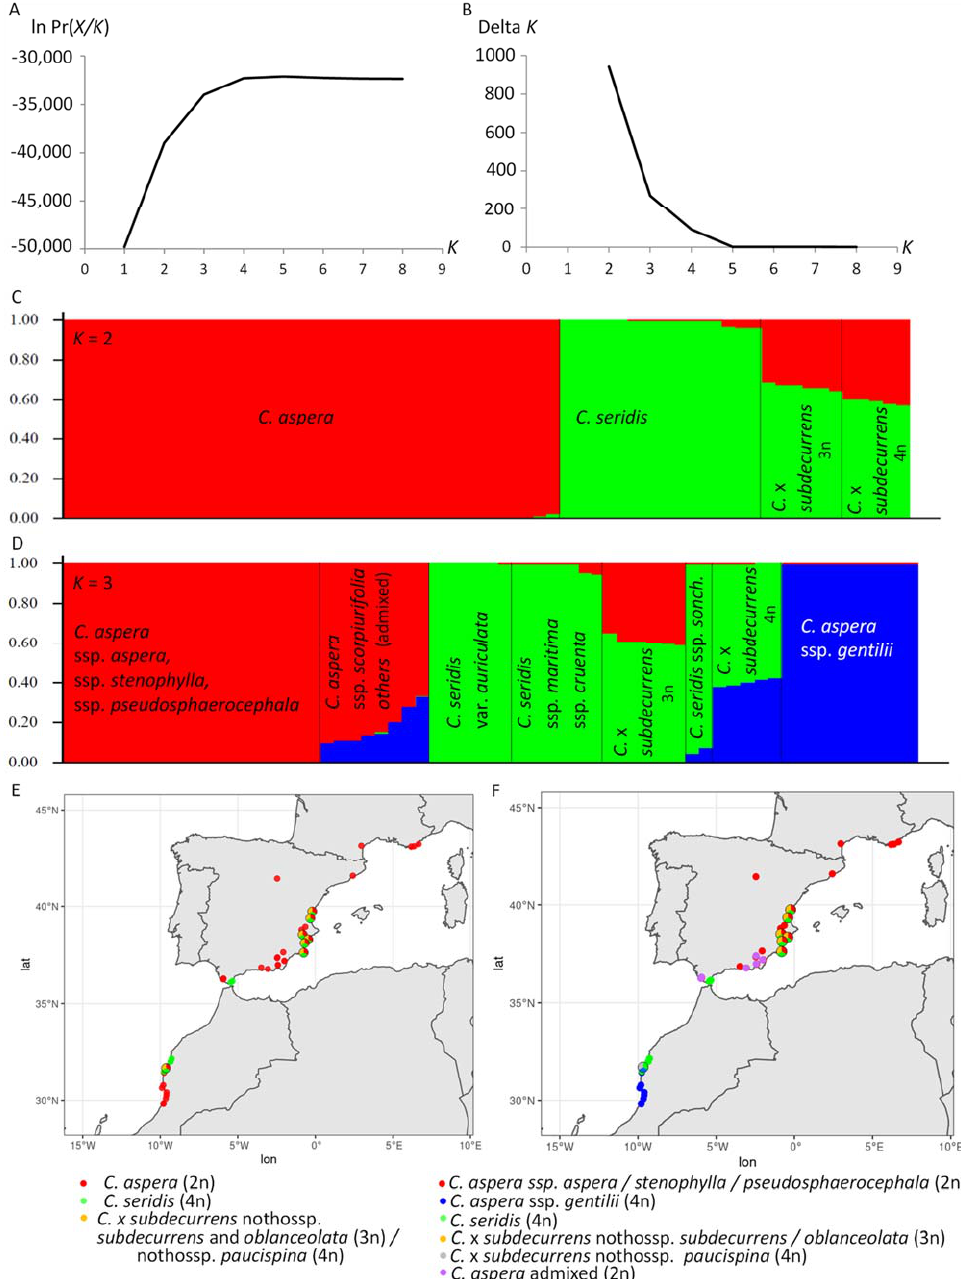
Figure 1. STRUCTURE clustering analysis for Centaurea aspera , C. seridis and C. x subdecurrens hybrids between them in the studied area. ( A ) Diagram representing log-likelihood of the SNP data for Centaurea individuals given K clusters obtained through 10 runs with the algorithm. ( B ) Diagram representing Delta K statistics of Evanno et al. [37]. ( C ) Diagram representing alignment tests for number of clusters K = 2, and ( D ) K = 3, with individual plants represented by columns and taxonomic adscription of individuals indicated. ( E ) Geographic location of STRUCTURE clusters with K = 2, and ( F ) K = 3. Pie charts are depicted in contact zones. Maps were made with Natural Earth (https://www.naturalearthdata.com/ accessed on 1 June